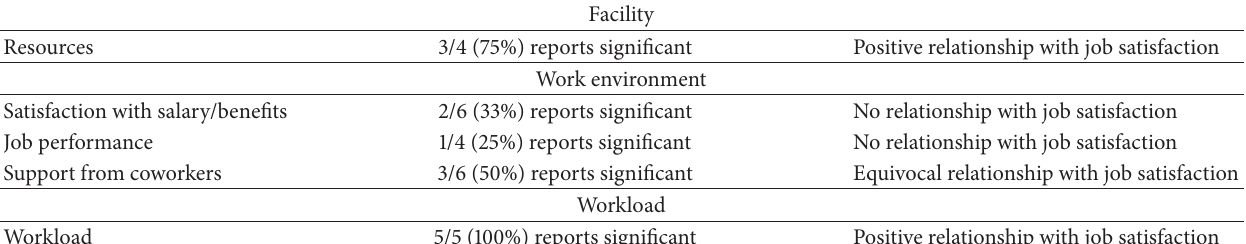
Table 6: Organizational factor